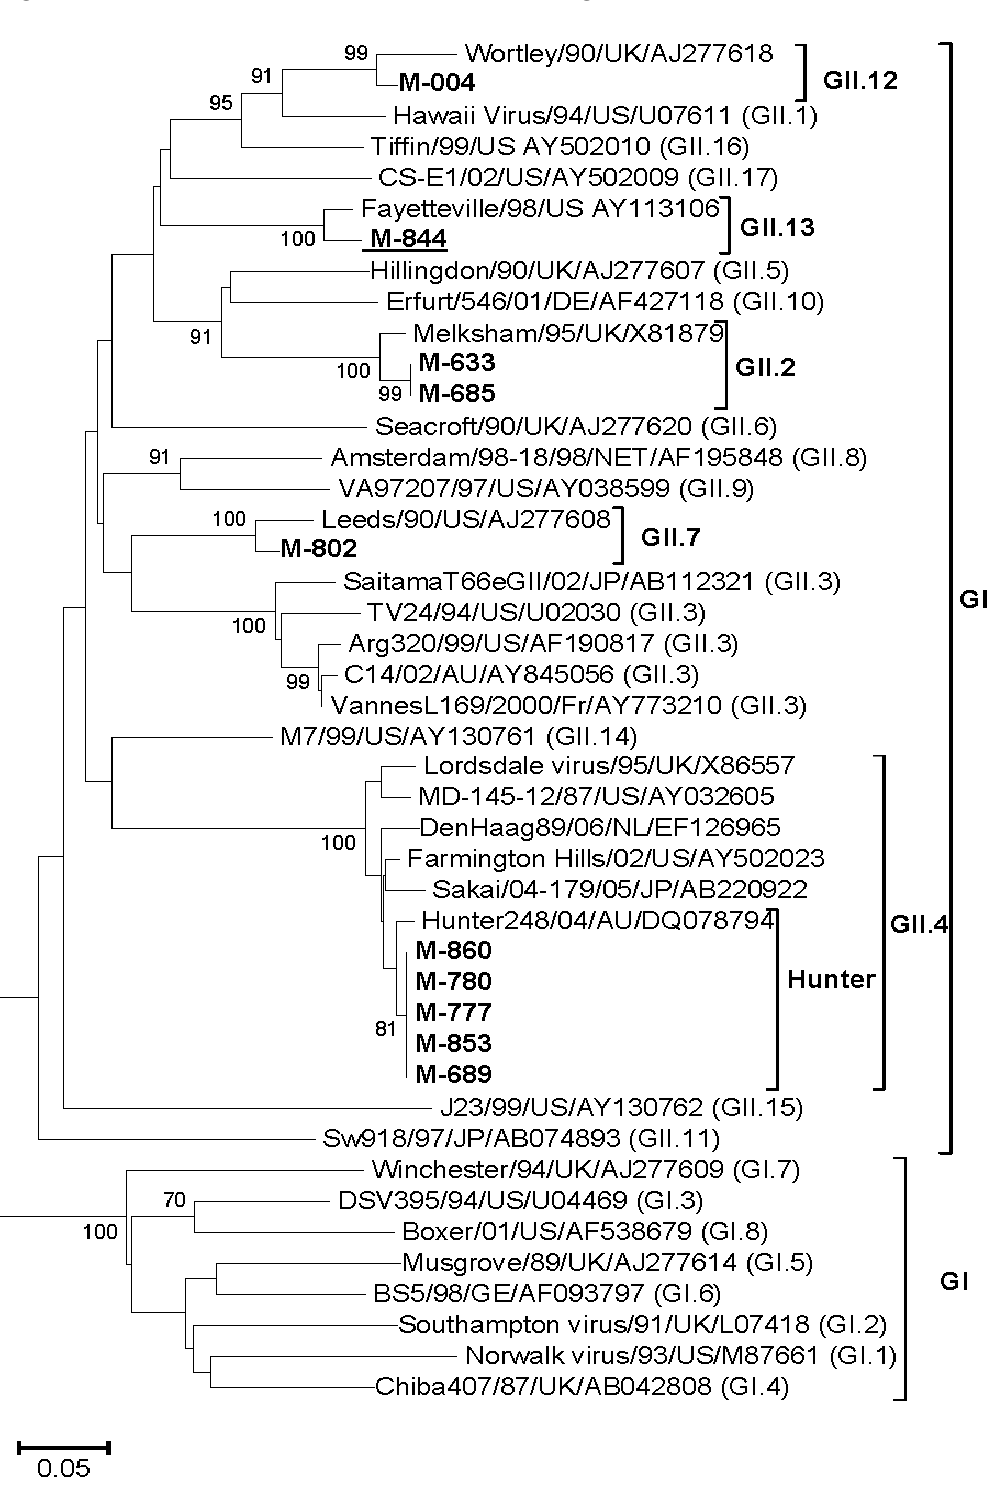
Figure 4. Phylogenetic tree based on the partial nucleotide sequences of VP1 gene (300 bp) of NoV strains. The strains of the present study are in bold face and the strain indicating recombination is underlined. Scale indicates genetic